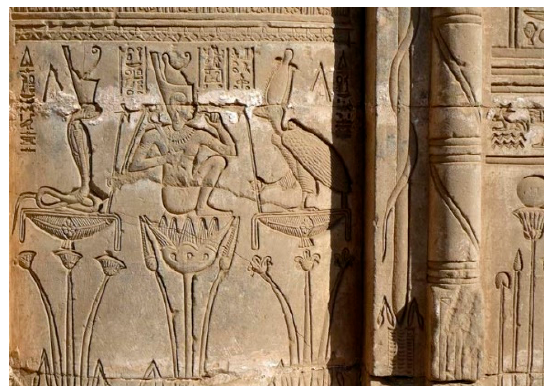
Figure 24. Relief depicting God Ihy at Dendera (Egypt). © Marie-Hélène Cingal.